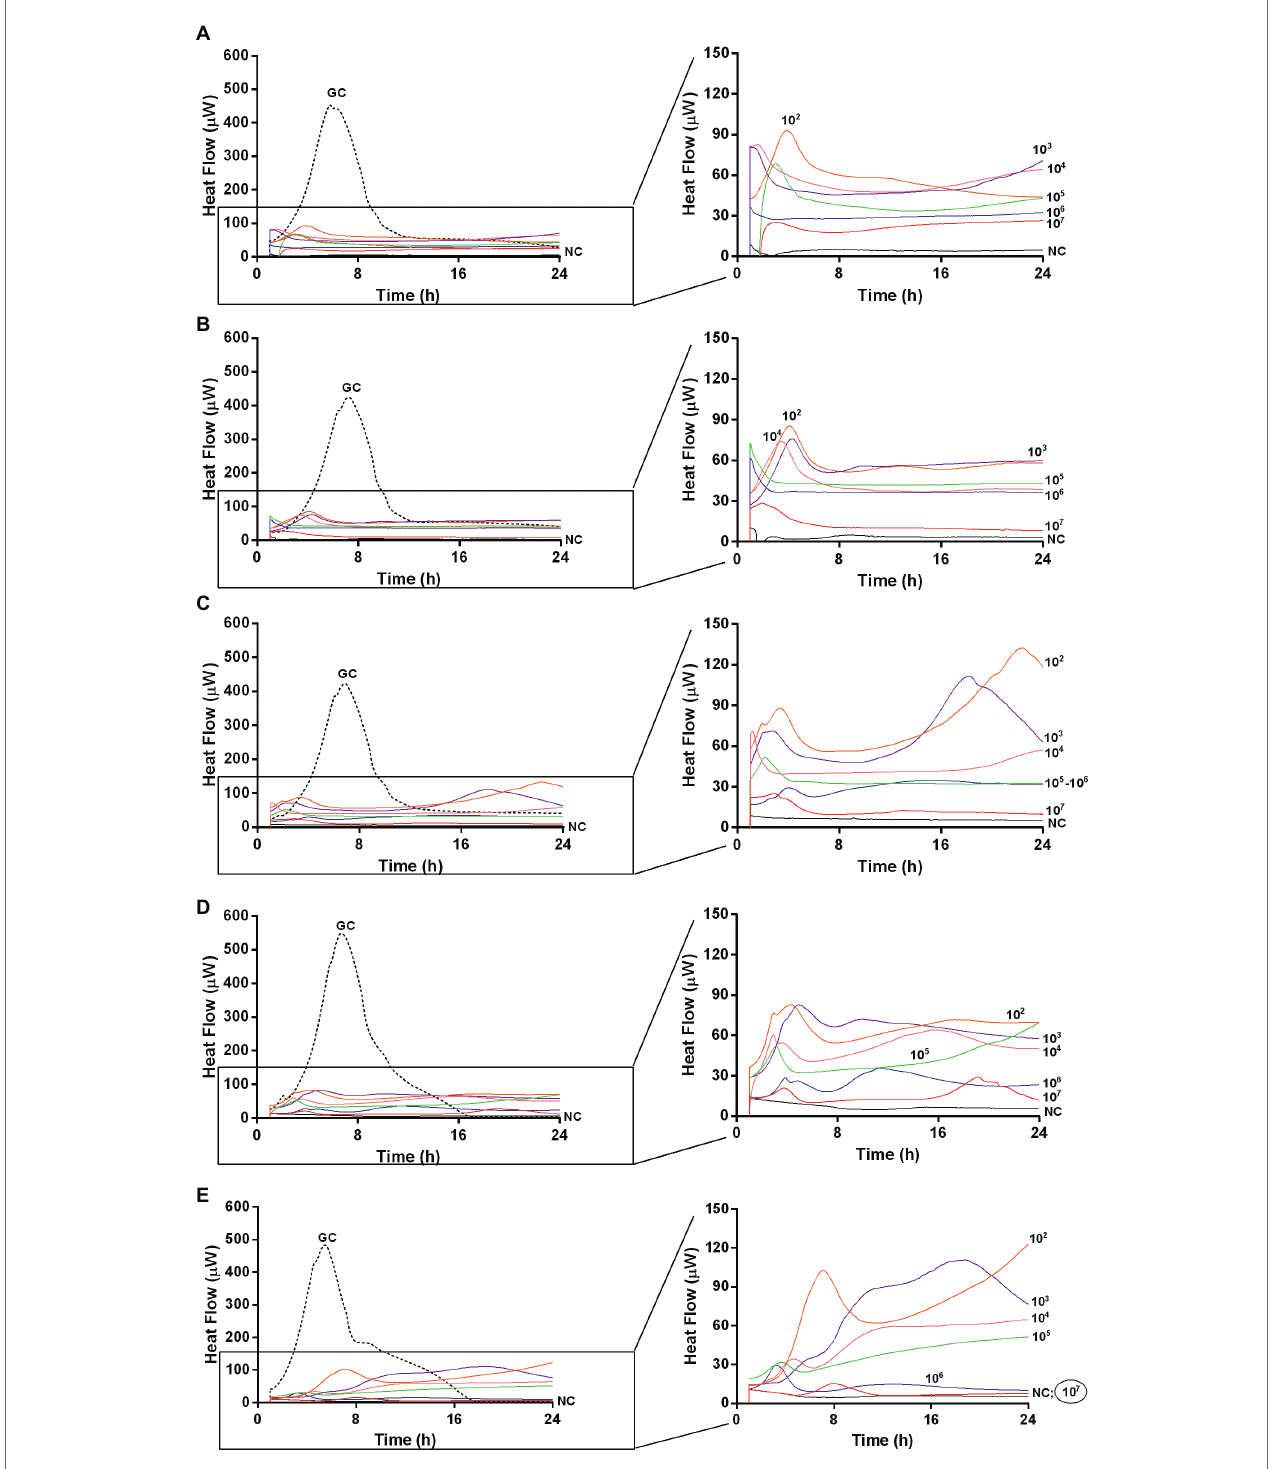
FIGURE 5 | Evaluation of MRSA ATCC43300 biofilm susceptibility to Sb phage at different time exposures by IMC. Each curve shows the heat produced by viable bacteria present in the biofilm after 24 h (A) , 48 h (B) , 72 h (C) , 120 h (D) , 168 h (E) , treatment with different phage titers (ranging from 10 2 to 10 7 PFU/ml). Graphs on the right represent the magnification of the graphs on the left. Numbers above curves represent Sb titers (in PFU/ml). Circled values represent the MBEC. GC, growth control (dashed line); NC, negative